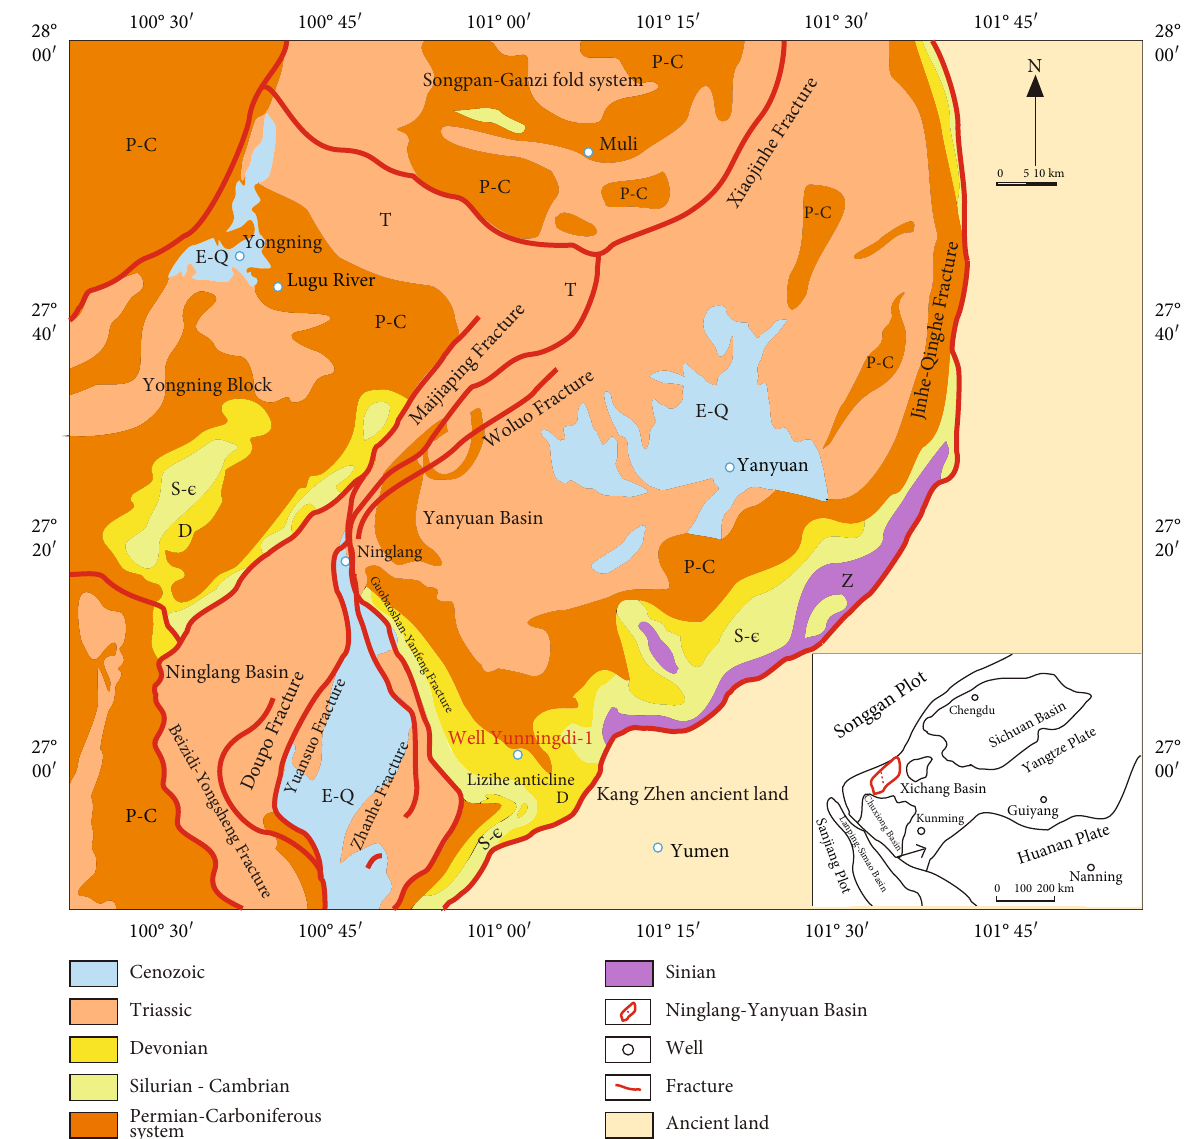
Figure 2: Tectonic position of the Ninglang-Yanyuan Basin and Well Yunningdi-1 (modi fi ed from reference